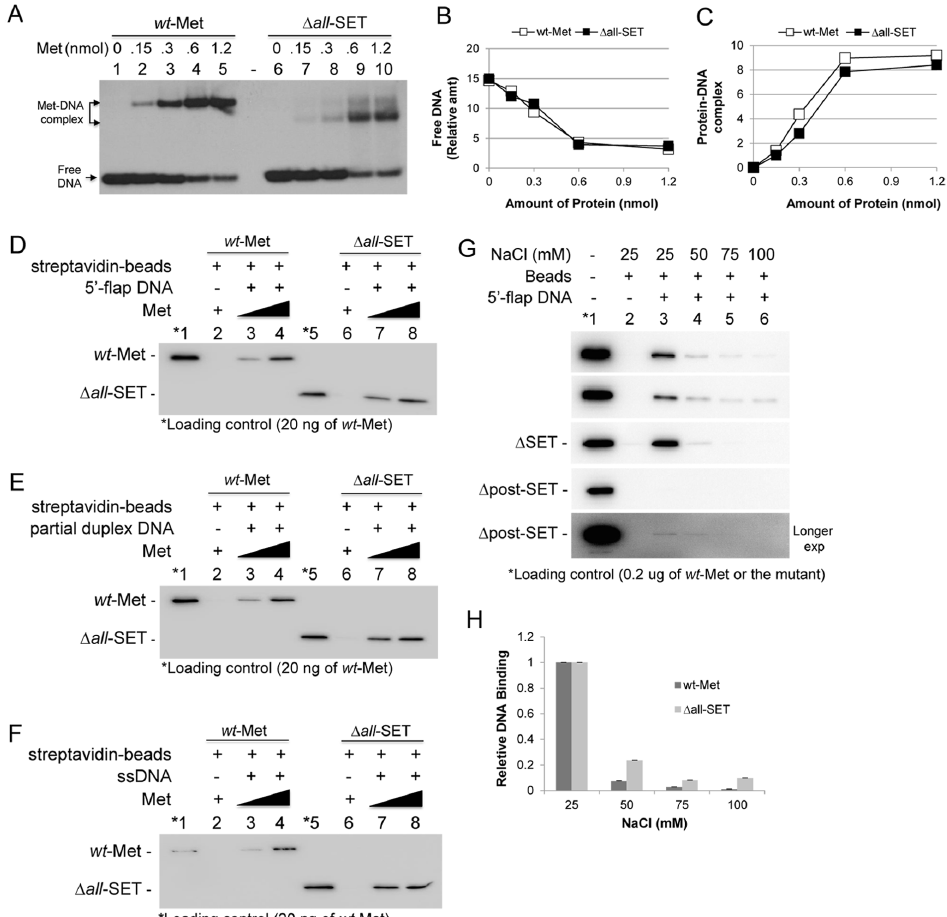
Fig 7. The Metnase SET domain is not involved in the Metnase-DNA interaction. (A) Indicated amounts of wt-Metnase or the Δ all -SET mutant were incubated with 400 fmol of 5 ’ - 32 P-labeled TIR DNA. Following 15 min incubation at 25°C, the protein – DNA complexes were analyzed by 5% native PAGE in the presence of 1X TBE. (B-C) Quantitation of free DNA and the Metnase-TIR complex. For quantitation, individual bands were excised from dried gel and measured for radioactivity. (D-F) Interaction of wt-Metnase and the SET deletion mutant ( Δ all -SET) with DNA using Streptavidine pulldown assay. Flag- tagged wt -Metnase or Δ all -SET protein (1.0 and 2.0 μ g) was incubated with 50 pmol of the 3 ’ -biotinylated 5 ’ -flap DNA (panel D), a partial duplex DNA (panel E), or ssDNA (panel F) for protein-DNA binding by Streptavidin-agarose beads (see Experimental Procedures for the details). The protein-DNA interaction was analyzed by Western blot using an anti-flag antibody. (G) Salt sensitivity of wt-Metnase and the SET deletion mutants in their interaction with a 5 ’ -flap DNA. Wt-Metnase or the SET deletion mutant (2.0 μ g) was incubated with 50 pmol of the 3 ’ -biotinylated 5 ’ -flap DNA in the presence of varying concentrations of NaCl prior to DNA pull-down with streptavidin-agarose beads. The protein-DNA interaction was analyzed by Western blot using an anti-flag antibody. (H) The protein-DNA complexes (panel G) were quantified by Molecular Imager ChemiDoc XRS using Quantity One 1 analysis software program